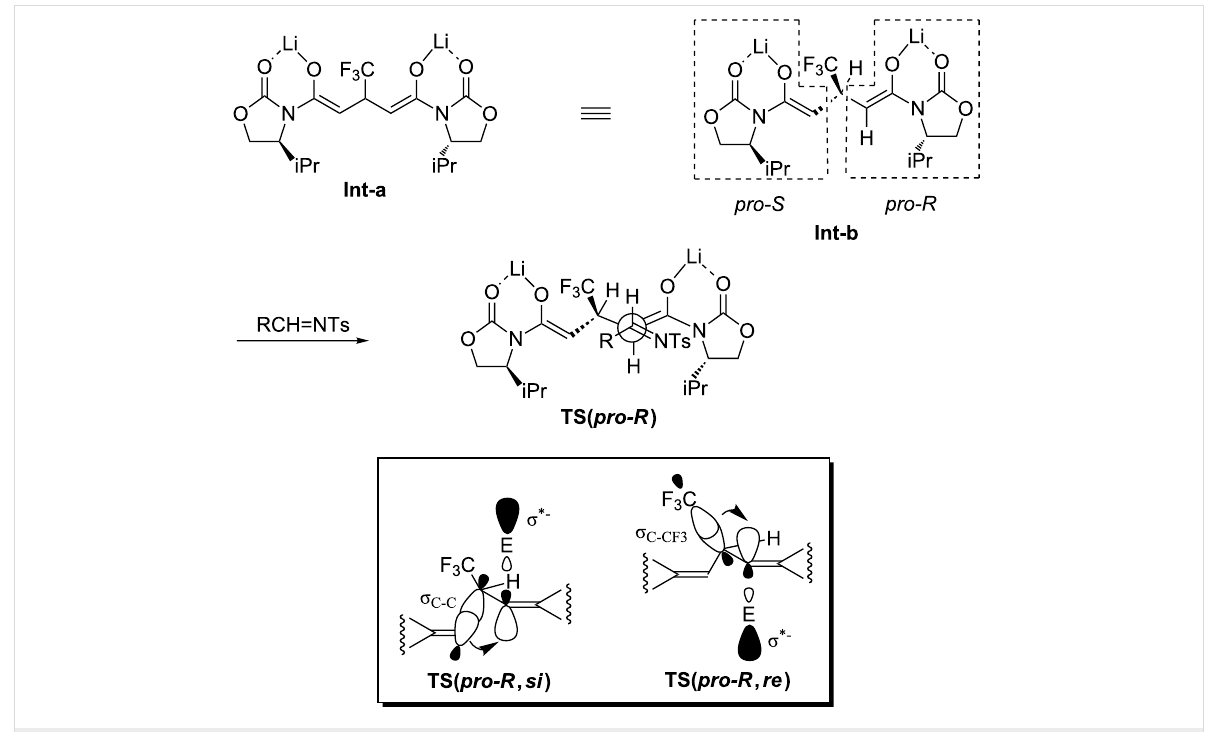
Scheme 1: Explanation of the construction of the main